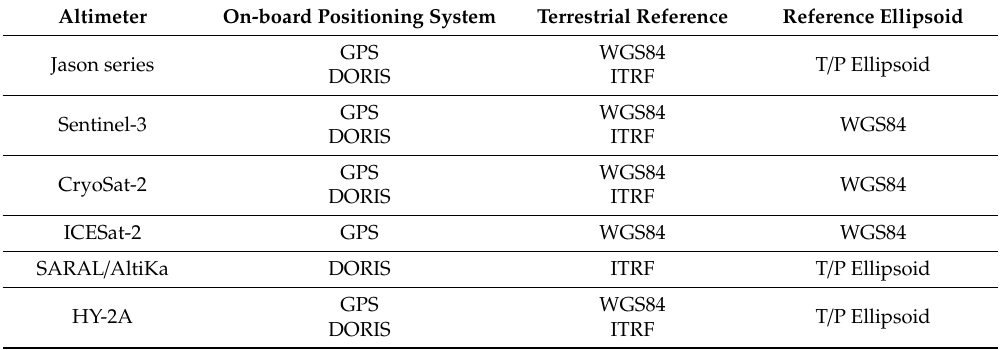
Figure 14. Relation of errors in the GPS vertical velocities with respect to length of observation (after [37]).